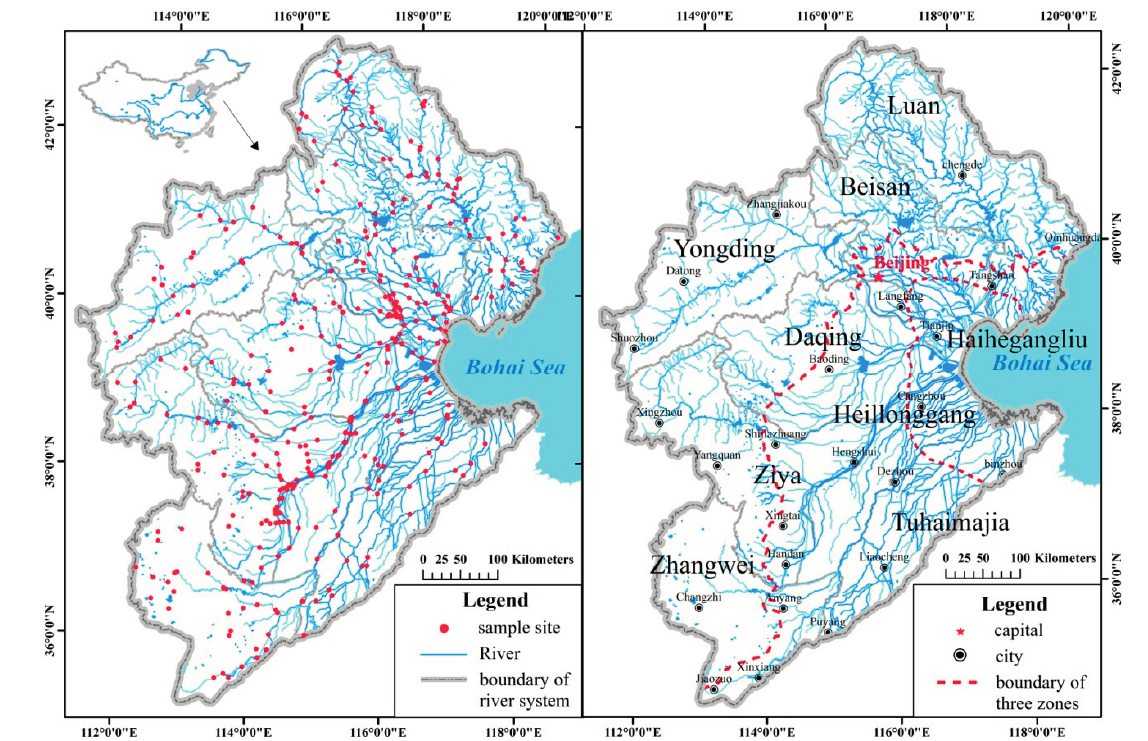
Figure 1. River system and sampling sites in Hai River